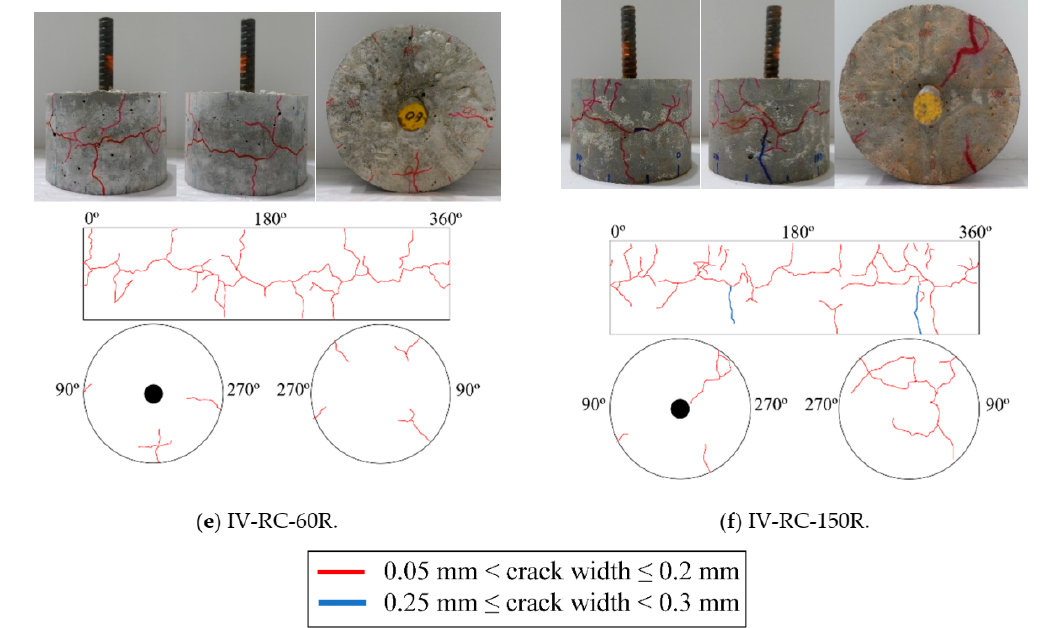
Figure 14. Specimen surface cracking for series IV after repeated cycles of high water pressure.